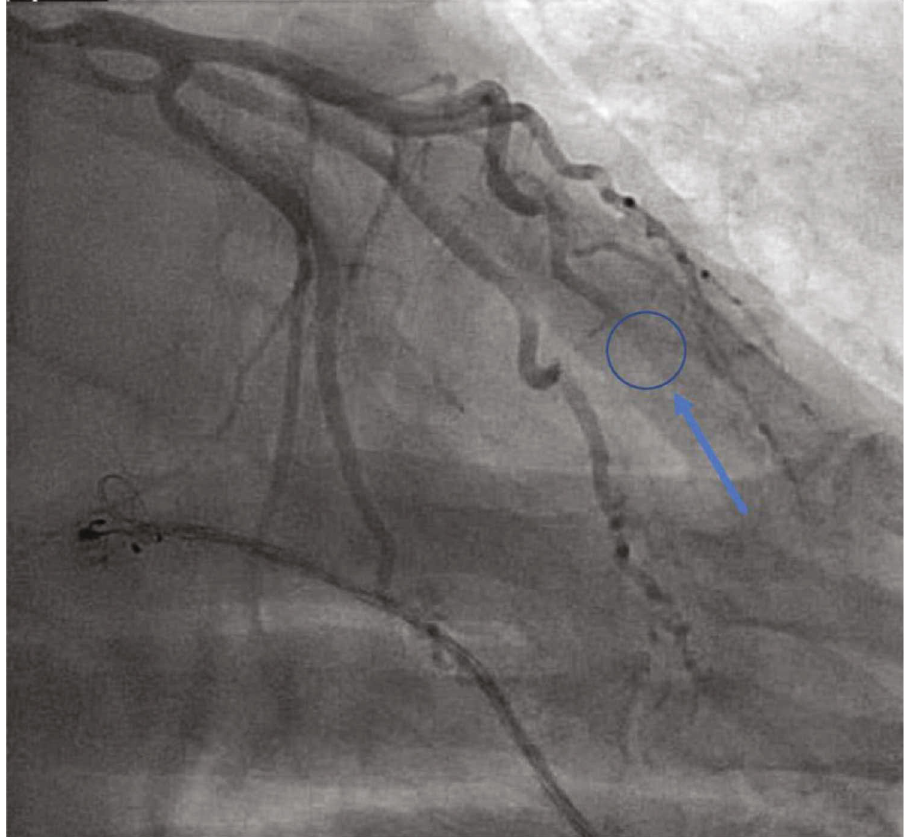
Figure 2: Left heart catheterization via the right radial approach. Selective angiograph of the left coronary artery in the right anterior oblique caudal projection revealing a no signi fi cant atherosclerotic disease but with a fi lling defect noted in the distal left anterior descending artery.